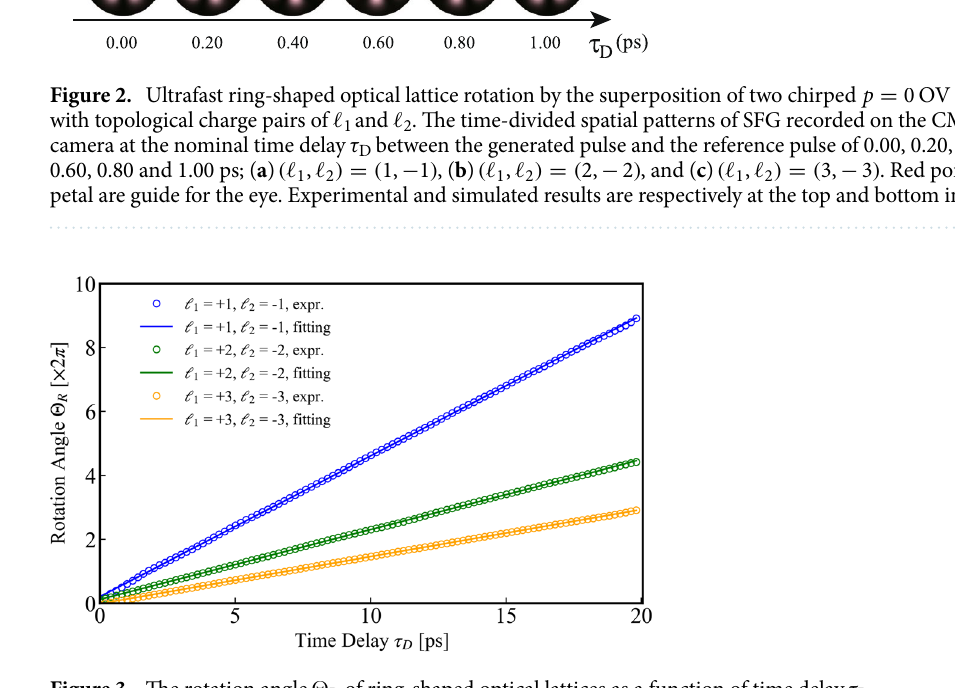
Figure 3. The rotation angle (cid:31) R of ring-shaped optical lattices as a function of time delay τ D